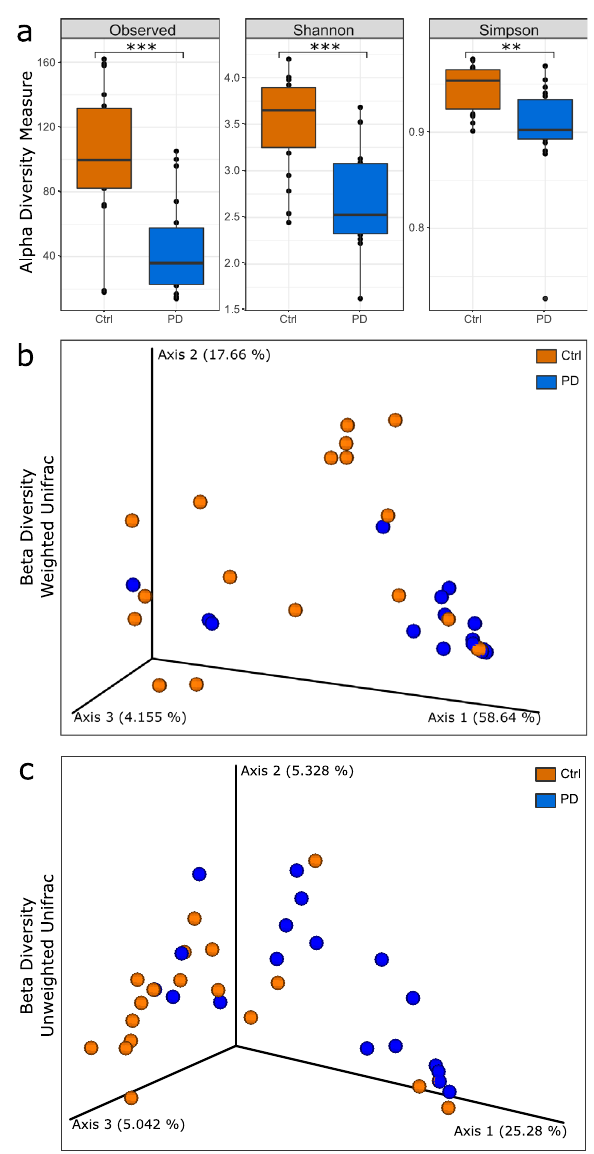
Fig. 2 Alpha and beta-diversity plots for visualization of the eukaryotic community structure and according to differences between the control group and PD patients. PD samples are displayed in blue and control samples in orange. With Observed, Shannon and Simpson, the three most common used indices for alpha diversity are shown in ( a ). Alpha-diversity boxplots consist of the median and lower and upper quartiles while the whiskers represent the mininmal and maximal spread of individual samples. Signi fi cant differences between the groups are indicated with asterisks (*** p < 0.001, ** p < 0.01). For beta-diversity, PCoA plots of the weighted ( b ) and unweighted ( c ) UniFrac measures are shown. Both beta-diversity measures show signi fi cant differences between controls and